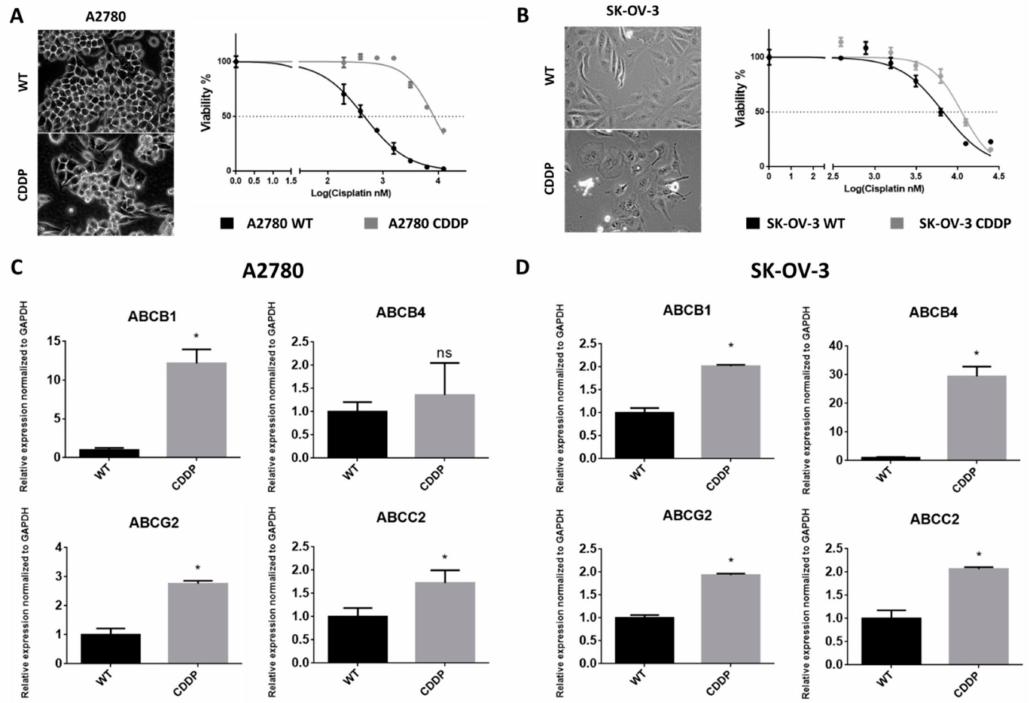
Figure 2. Overview of cisplatin-resistant ovarian cancer cell lines (A2780, SK-OV-3). ( A , B ) Morphological changes of both drug-resistant cancer sub-lines represent enlargement and slight spindle-like shape. Survival curves indicate increased IC 50 for both resistant variants (RI = 18.08 for A2780; RI = 1.56 for SK-OV-3). The pictures were taken under 200 × magnification. ( C , D ) RT-qPCR analysis of A2780 and SK-OV-3 revealed significantly increased expression of ABC drug transporters in derived resistant